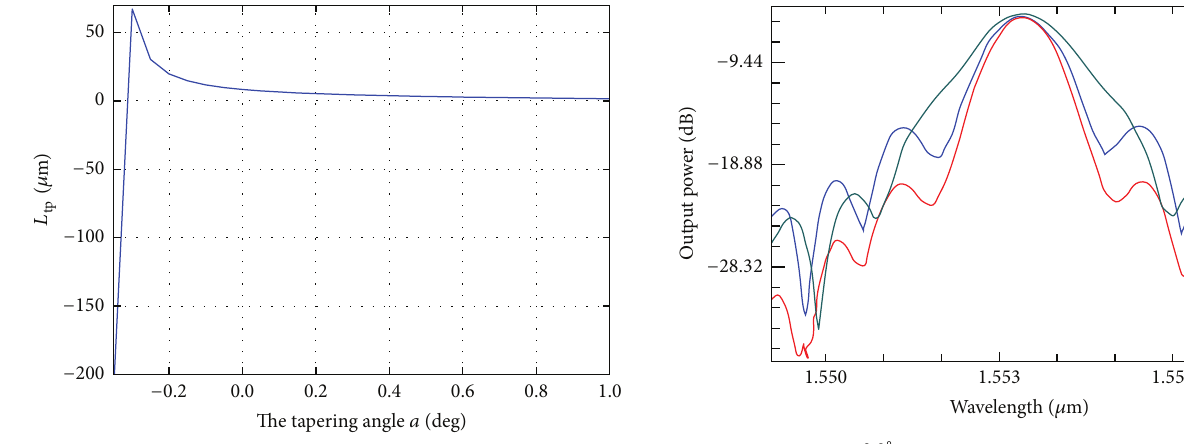
Figure 6: The length 𝐿 of the tapered MMI as the tapering angle tp 𝑎 varies.